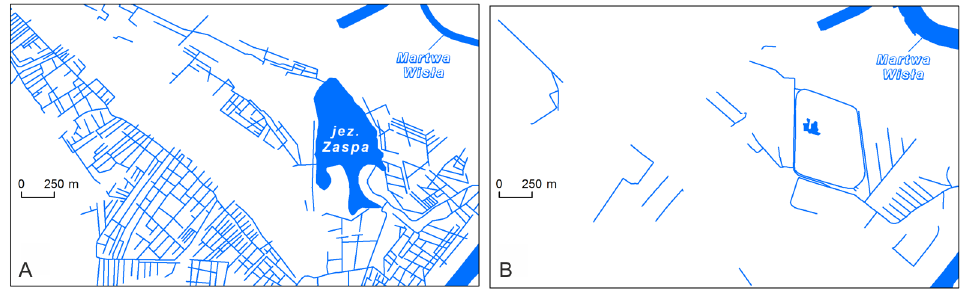
Fig. 4. Water network of a low located fragment of the city of Gdańsk: A – at the end of the 19th century, recreated according to Messtischblätter topographic map at the scale of 1:25,000, B – current state according